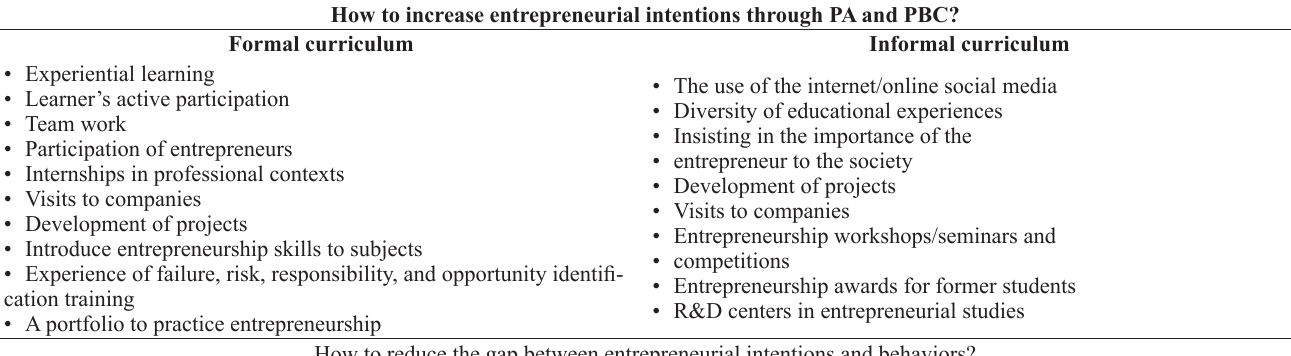
Table 3. Suggestions to improve curriculum design and